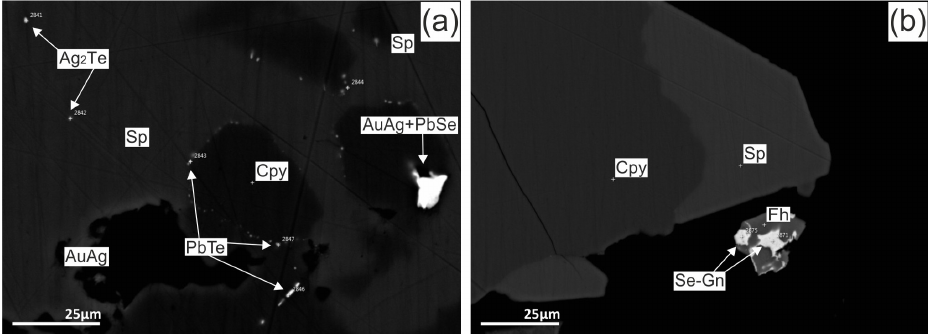
Figure 7. Au and Te minerals of chalcopyrite-sphalerite chimneys (active). BSE photographs. ( a ) Numerous hessite (Ag 2 Te) and altaite (PbTe), intergrowths of electrum (AuAg) and clausthalite (PbSe) along the boundaries of chalcopyrite-sphalerite graphic intergrowths; ( b ) Se-galena (PbS,Se) and fahlore (fh)